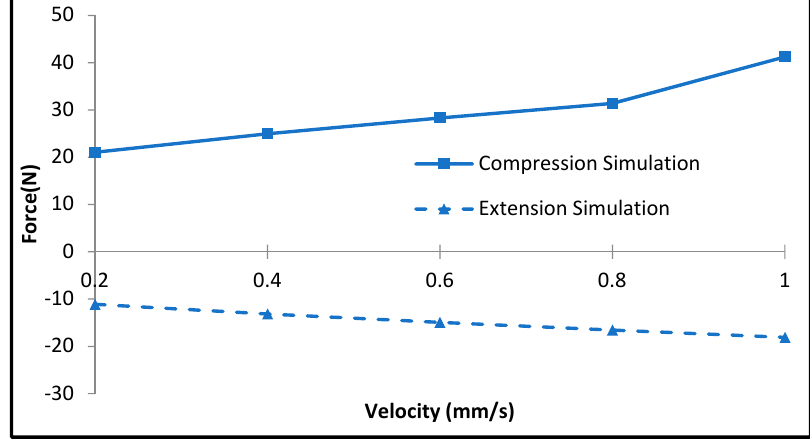
Figure 9. O ff -state damping Figure 9. Off-state damping force.